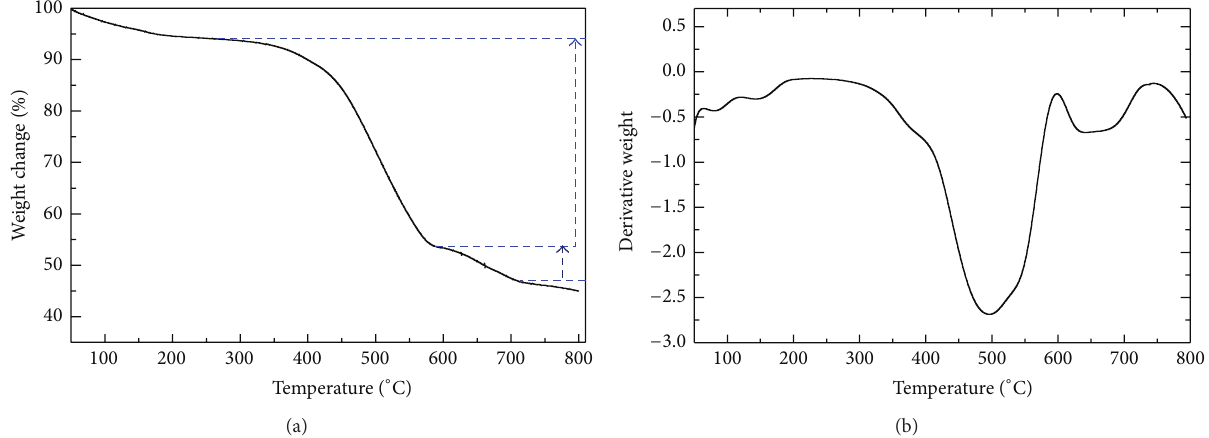
Figure 4: (a) TGA curve of C. polygonoides ash. (b) DTA curve of C. polygonoides ash.